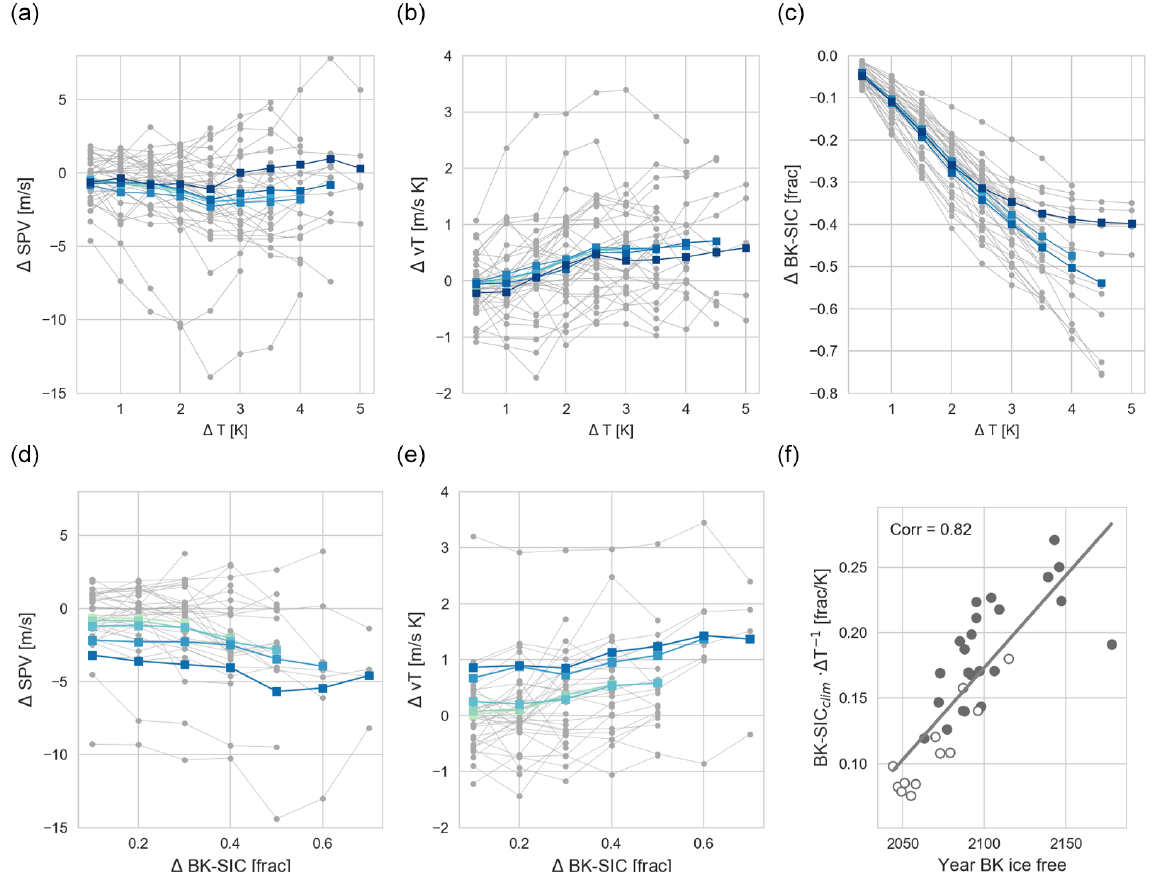
Figure 1. Non-linear response of the SPV to global warming. (a) SPV change in winter (January, February, March; JFM) as a function of annual mean global mean temperature change in the CMIP5 models (see methods). The thick blue lines show the ensemble mean for different sub-sets of the warming level reached at the end of the 21st century, with darker colours indicating higher warming levels. For example, the darkest blue line shows the ensemble mean for the set of models reaching 5K warming, while the second darkest line is the mean over all models reaching at least 4.5K warming (thus including those models also reaching 5K warming). (b) Same as (a) but for vT change (December, January, February; DJF). (c) Same as (a) but for BK-SIC change in autumn (October, November, December; OND). (d) Same as (a) but for SPV change as a function of BK-SIC change. (e) Same as (b) but for vT change as a function of BK-SIC change. (f) Estimated timing of an ice-free BK in OND versus its climatology in 1960–1989 divided by global mean temperature change at the end of the 21st century, i.e. the warming averaged over the 2070–2099 period. The dark circles indicate the models that have too much BK-SIC compared to observations and the open circles those with too little sea